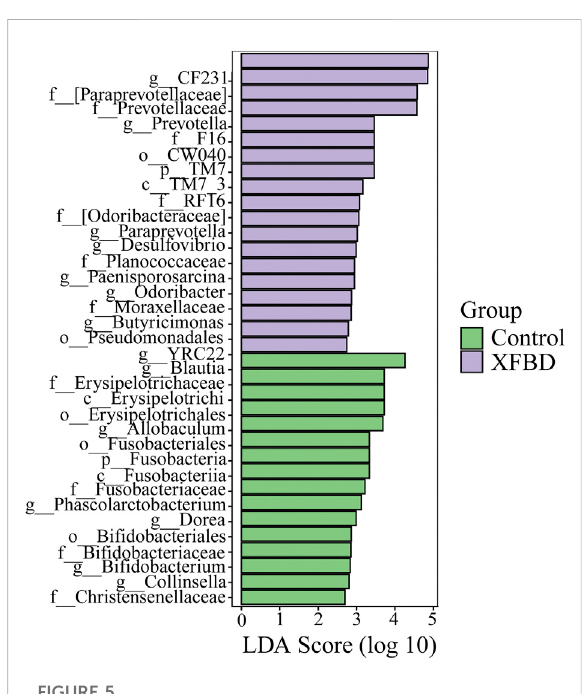
FIGURE 5 LEfSe analysis of differential abundant species as biomarkers between control and